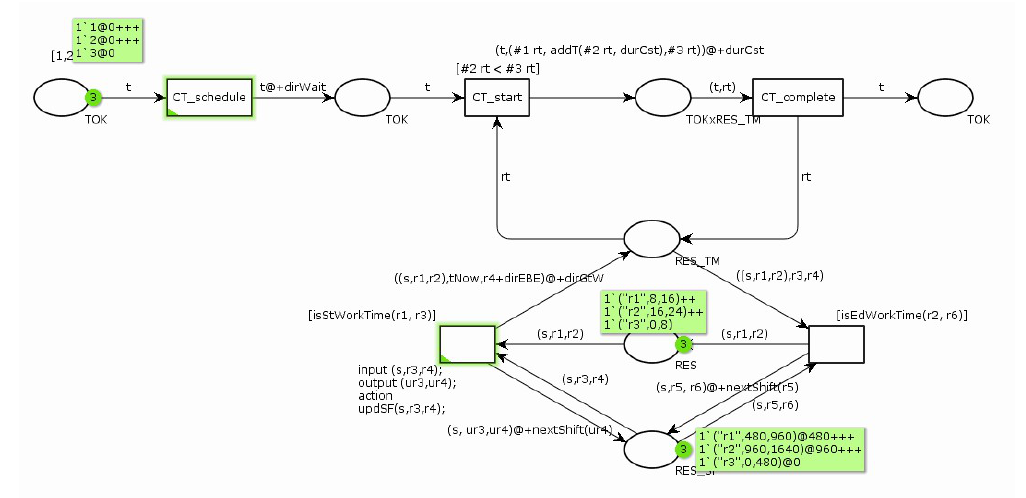
Figure 5. Part of the CPN model that incorporates the shift work rule.